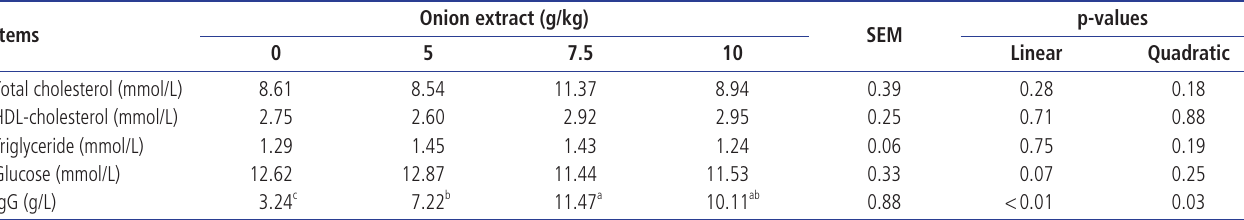
Onion extract (g/kg)